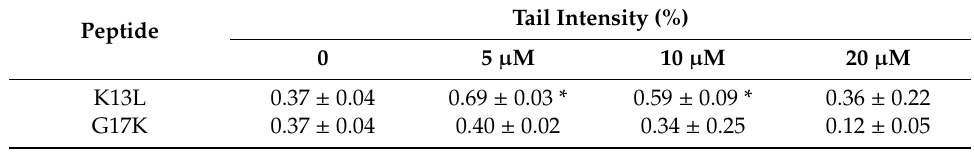
Table 5. In vitro genotoxic activity of selected